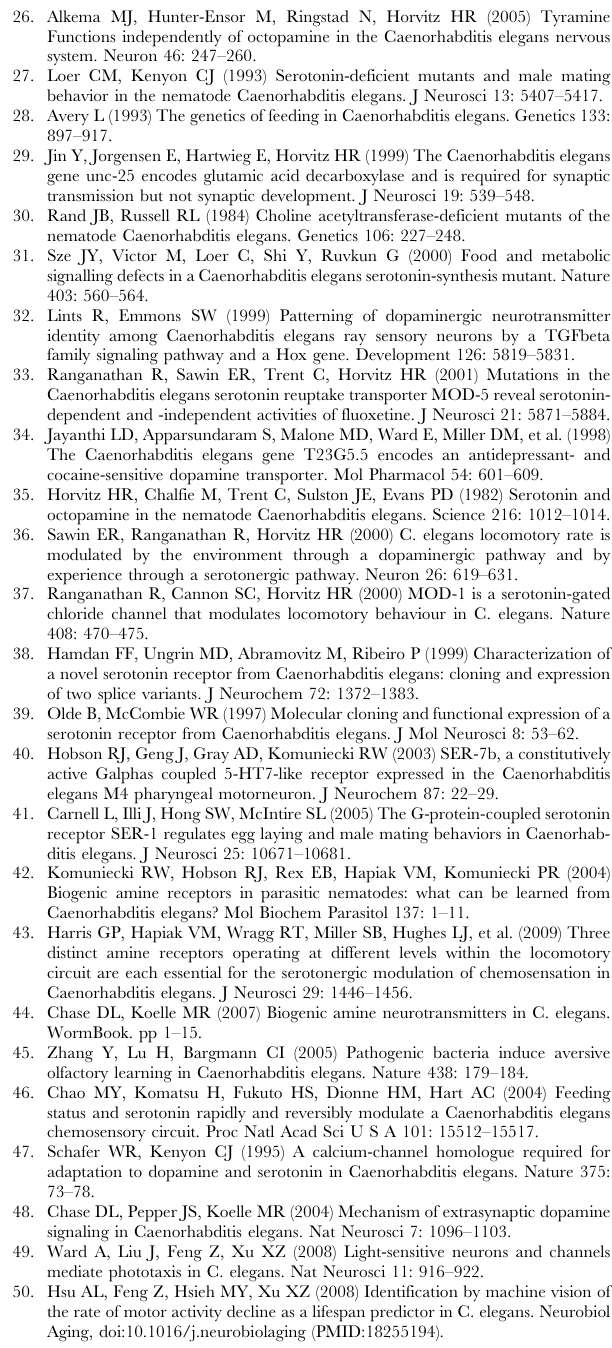
Table S1 Average locomotion velocity in naı¨ve and cocaine- treated worms Found at: doi:10.1371/journal.pone.0005946.s001 (0.39 MB